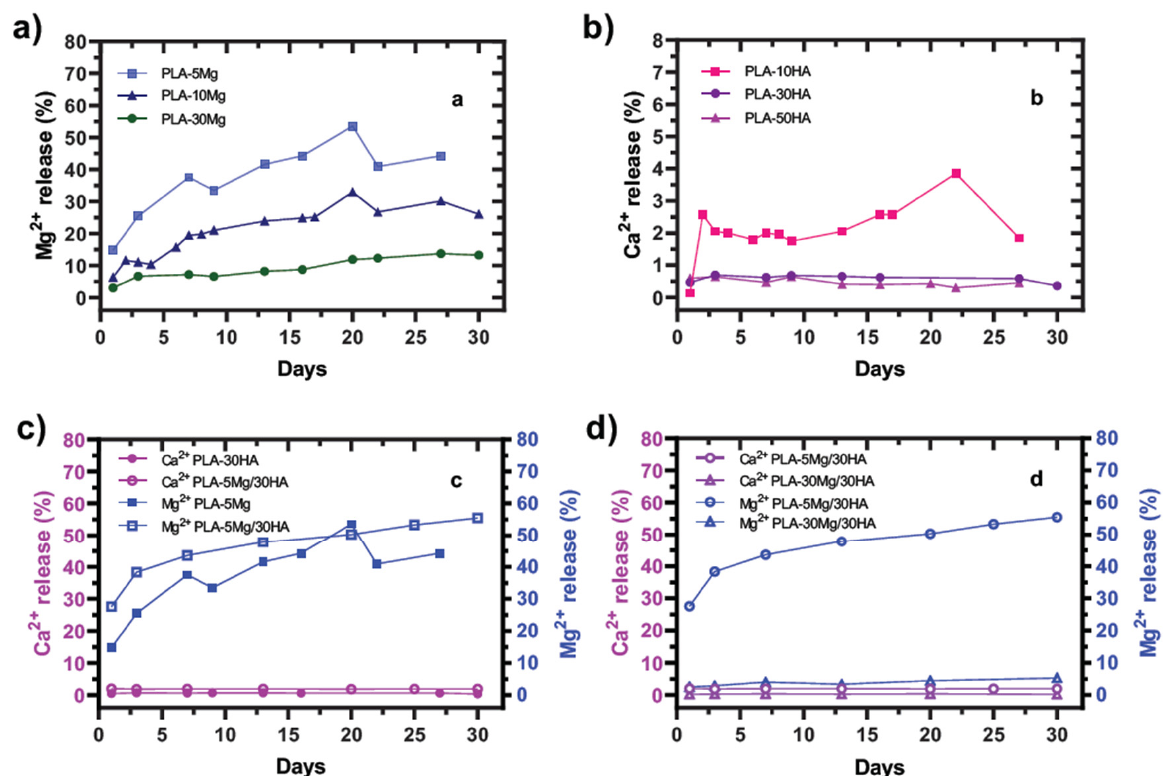
Figure 2. Evolution of Mg 2+ and Ca 2+ ions release at immersion in PBS. Data are shown normal- ized by the amount of Mg and Ca incorporated to the composites. ( a ) Mg 2+ release in PLA-5 Mg, PLA-10 Mg and PLA-30 Mg composites. ( b ) Ca 2+ release at PLA-10 HA, PLA-30 HA and PLA-50 HA composites. ( c , d ) Comparative evolution of Mg 2+ and Ca 2+ ions release in mono- and biphase- com- posites. ( c ) PLA-30 HA, PLA-5 Mg, and their biphase composite. ( d ) Release at PLA-5 Mg/30 HA and PLA-30 Mg/30 HA.